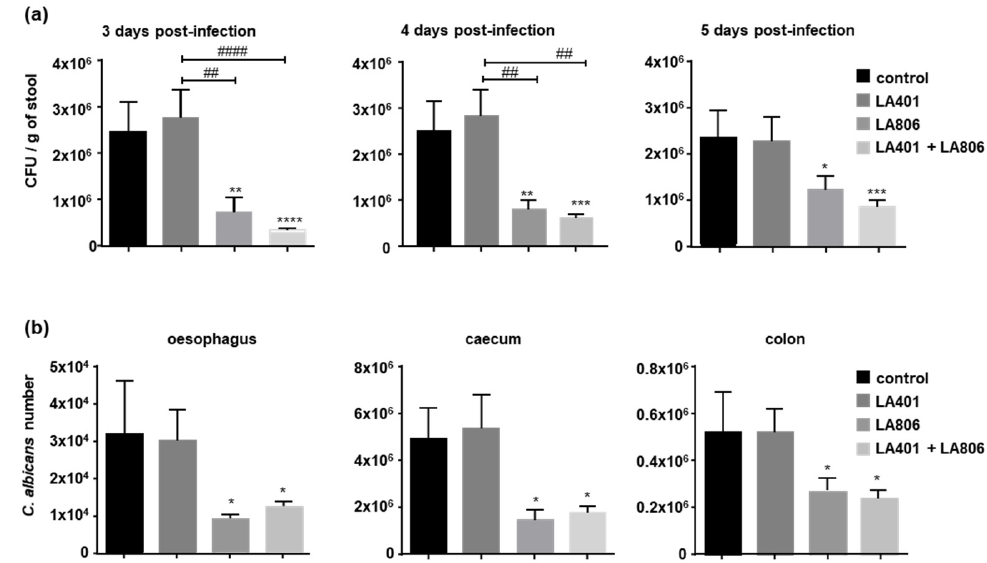
Figure 1. Effect of Lactobacillus helveticus LA401 and/or Lactobacillus gasseri LA806 oral administration on Candida burden. The bacterial strains (LA401, LA806 and combination of LA401 and LA806) were orally administered to mice ( n = 10 per experimental group) once a day, for 12 days before yeast colonization. Mice were orally infected with C. albicans at 50 × 10 6 blastospores per mouse. ( a ) Number of viable C. albicans were determined in stools collected at 3-, 4- and 5-days post C. albicans gavage. ( b ) On day 5 post C. albicans administration, mice were sacrificed and C. albicans colonization in the oesophagus, caecum and colon was assessed by quantitative RT-PCR. Data are presented as means ± SEM. * p ≤ 0.05, ** p ≤ 0.01, *** p ≤ 0.005, **** p ≤ 0.001 compared to control. ## p ≤ 0.01, #### p ≤ 0.001 compared to treatments.